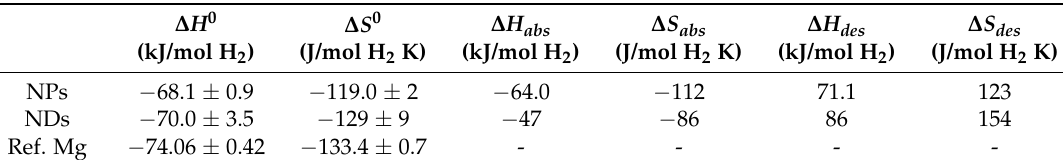
Table 1. Hydride formation enthalpy and entropy for a collection of Mg–Ti–H NPs with varying Ti content (6, 15, 30 atom %) and for Mg NDs (radius = 30 nm) corresponding to the linear fits displayed in Figure 5. ∆ H 0 and ∆ S 0 are determined by the linear fit of the equilibrium pressures. The data of reference bulk Mg are also listed [9]. The values obtained from the separate fits of absorption and desorption pressures reveal a discrepancy arising from hysteretic effects.